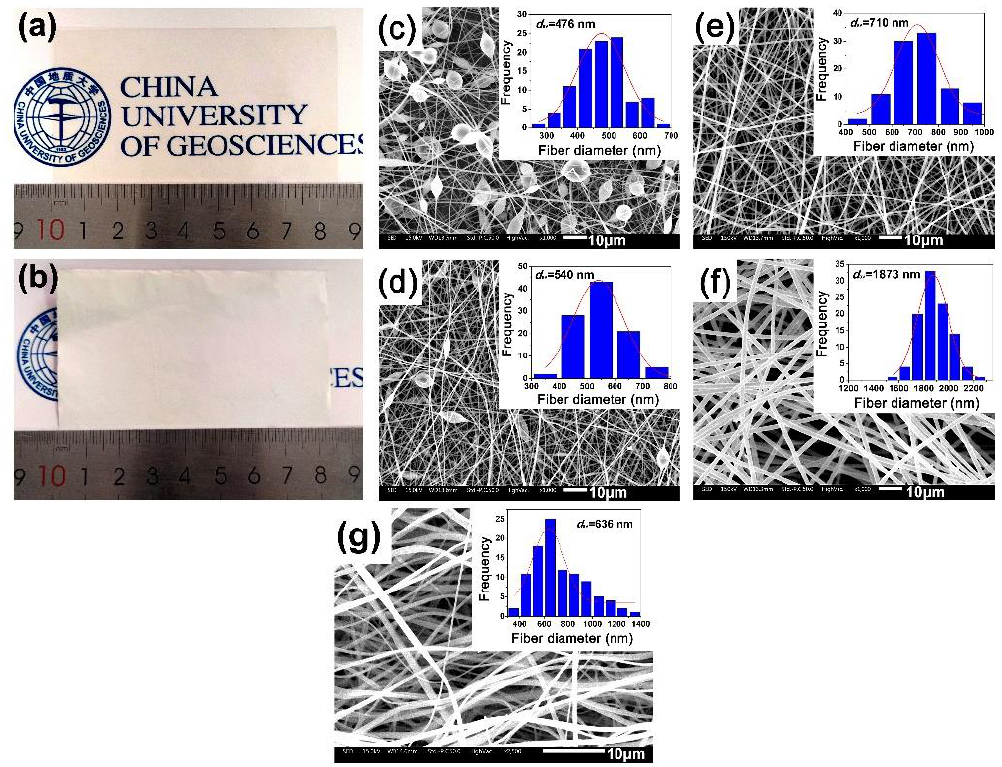
Figure 5. Preparation of PI NFM via electrospinning procedure from soluble PI resin.